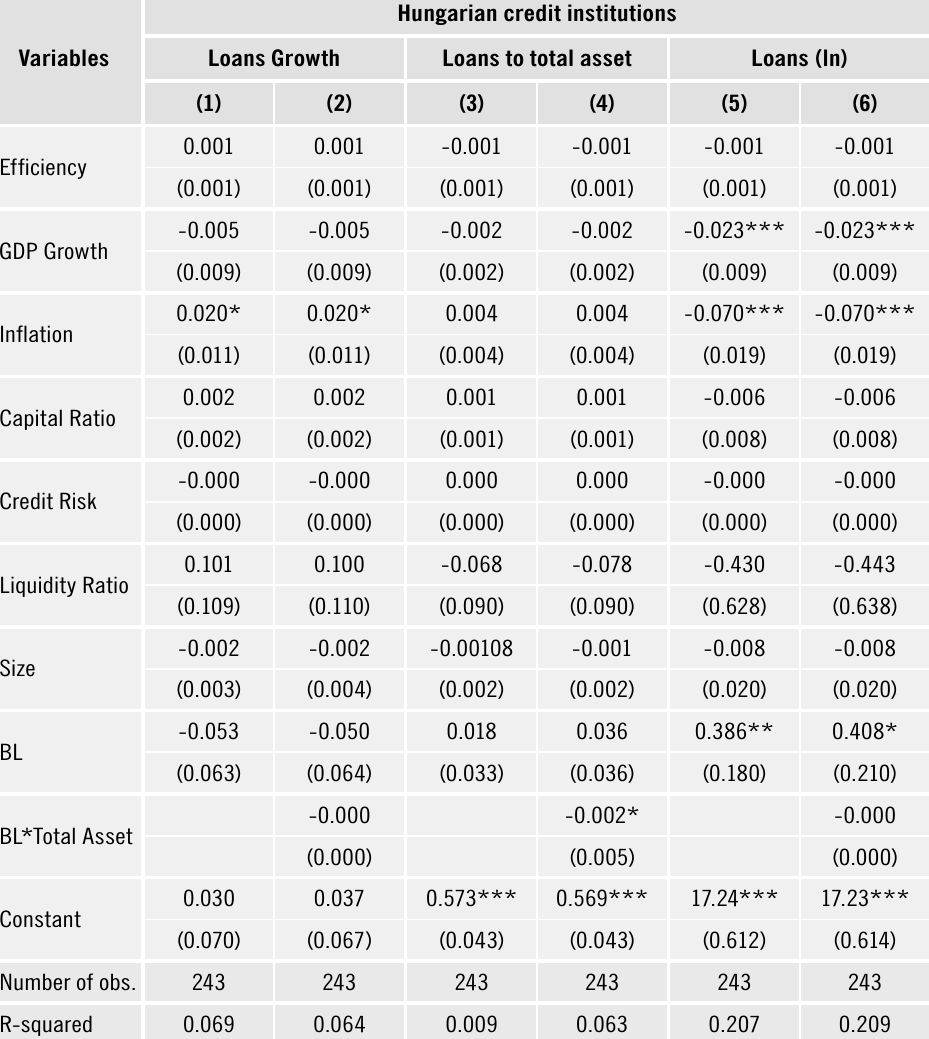
Table 9. Data presenting estimates based on GLS regressions with a random effect on Hungarian credit institutions in 2008–2015. Data have been sourced from unconsolidated financial statements. Institution-specific characteristics appear as one-year lagged variables in all specifications. The bank levy (BL) is represented by a dummy variable indicating 1 for all years the levy applies to, and zero for all remaining years. Robust standard errors that control for clustering at the bank level are reported in